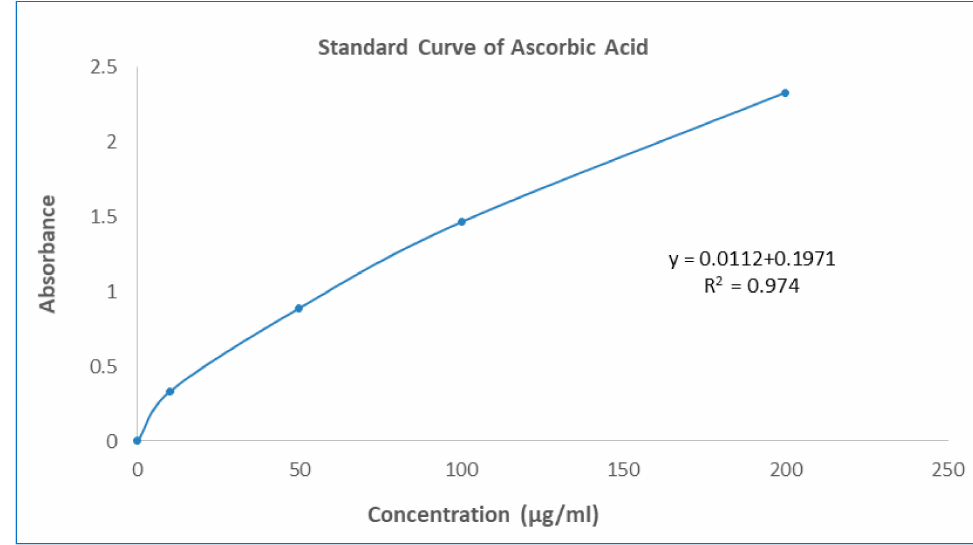
Figure 1. Standard curve of Ascorbic